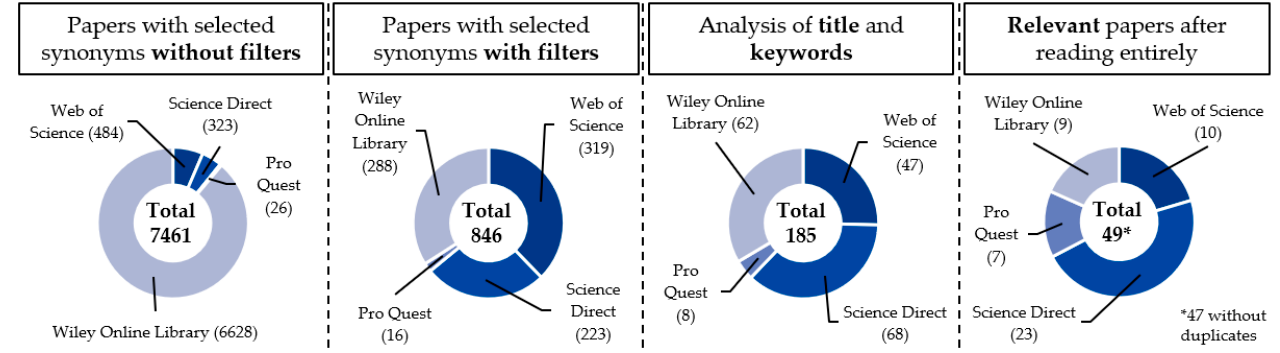
Figure 3. Results of the systematic literature review adapted from [23].